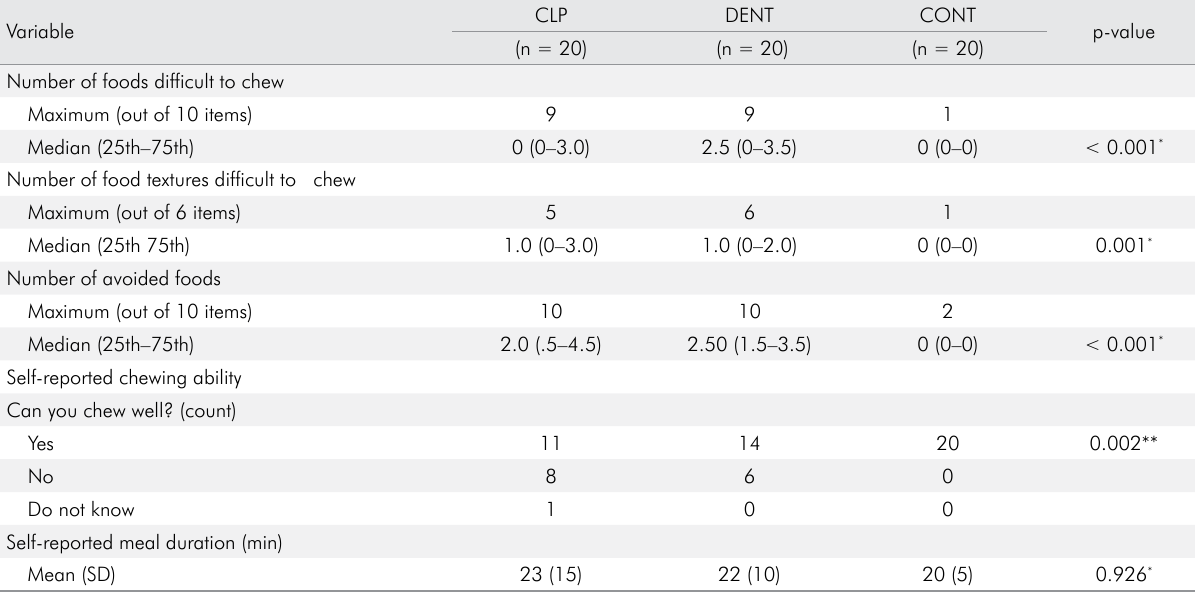
Table 4. Masticatory characteristics of the sample (n =